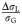
Trending ability of ΔSVEIT vs ΔSVRef shown by means of four-quadrant plots for the combination of the two features ΔσL and ΔσLσG and (a) a subject-independent calibration for hypothesis (H3) or (b) a subject-specific calibration for hypothesis (H4).The exclusion zone was set to ±30%.